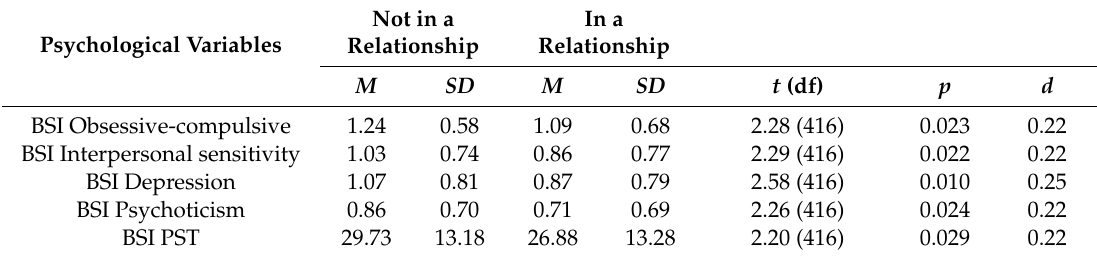
Table 6. Significant means di ff erences of relationship